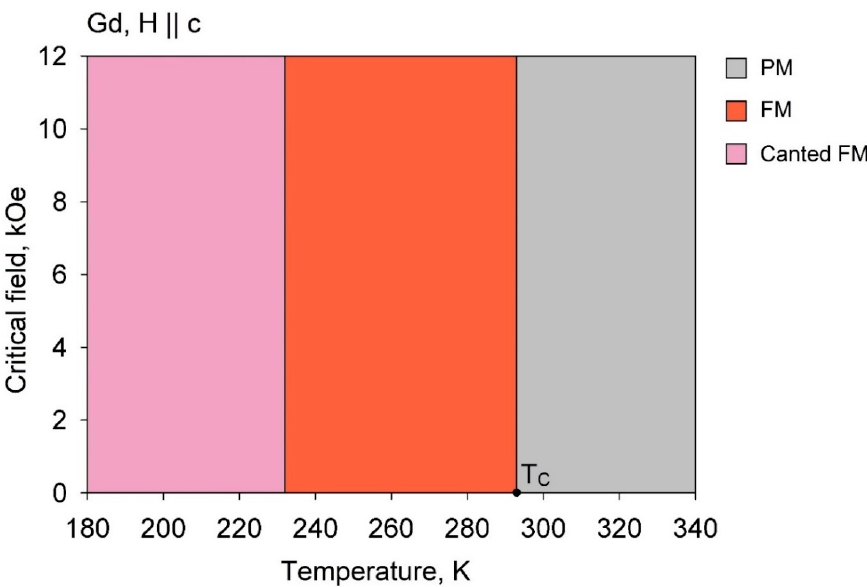
Figure 2. Magnetic phase diagram of Gd. The experimental data has been taken from [72].